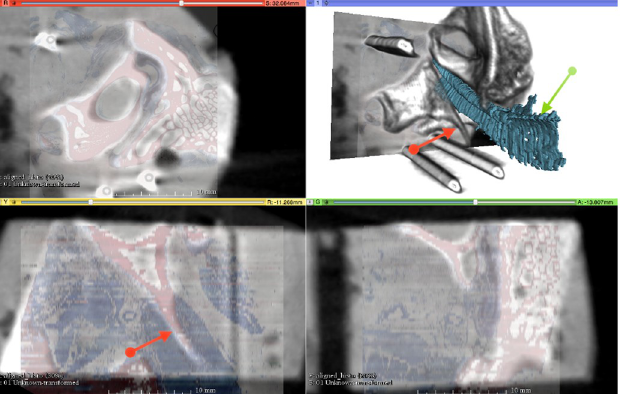
Fig 4. Fusion of the histologic 3D model and the CBCT. Note the marking cannulas for reference in the reconstruction (top right) with superimposed tubal cartilage (petrol). The three multiplanar para-planes with superimposed histological section (colored) into the CBCT (grey) come from the upper left (coronary, corresponding histologic section—plane of segmentation: red: bone, blue: soft tissue) over lower left and lower right (sagittal and axial, with reconstructed histological section: slice thickness in the form of jumps). Red arrow: corresponding bony process of the skull base. Green arrow: cartilage of the ET.